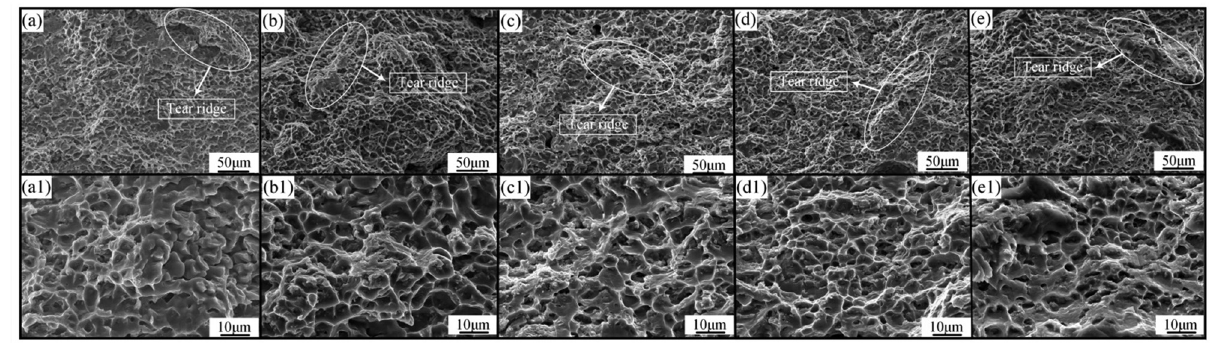
Figure 14: SEM fractographs of weld joints made with different frequencies: ( a and a1 ) 0 kHz, ( b and b1 ) 40 kHz, ( c and c1 ) 50 kHz, ( d and d1 ) 60 kHz, and ( e and e1 ) 70